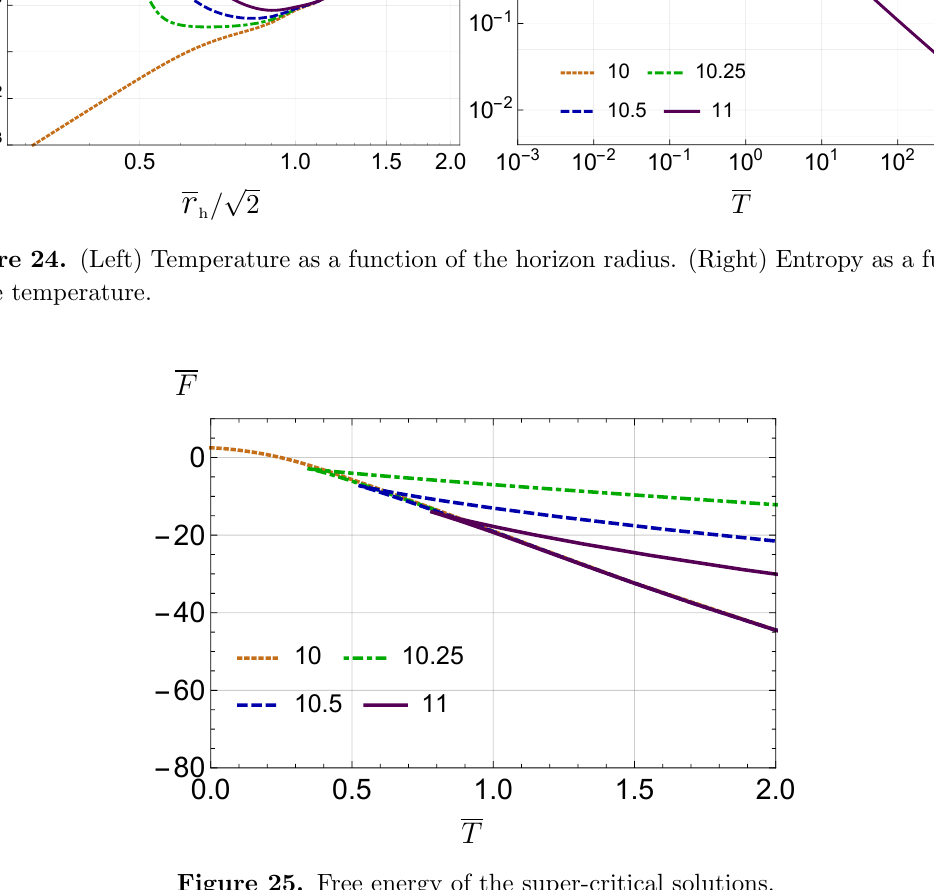
Figure 25. Free energy of the super-critical